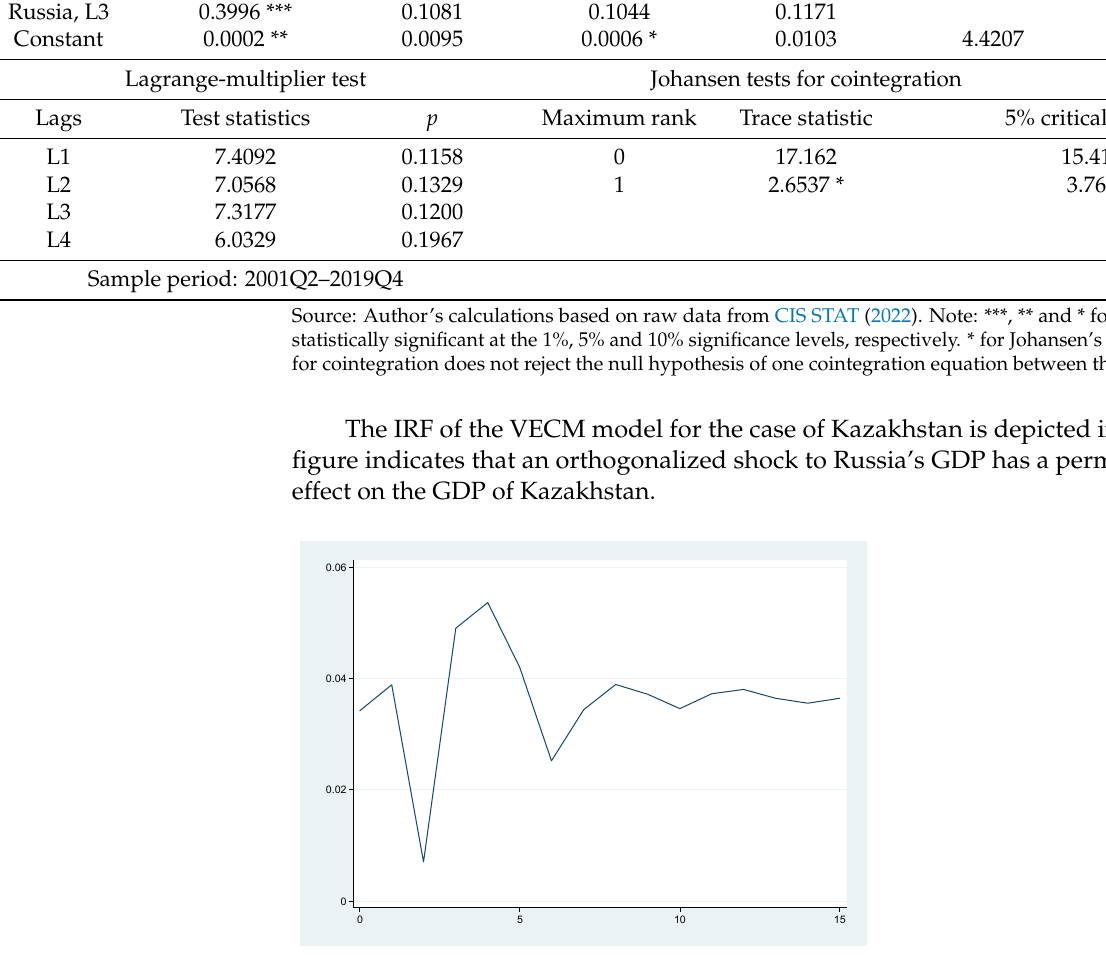
Figure 4. Impulse Response Functions (IRFs) of the VECM Model, Kazakhstan. Note: Response of Kazakhstan’s GDP to the Russian GDP.